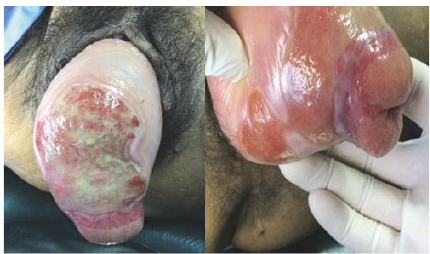
Figure 1: The prolapsed uterus was nonreducible due to the inflamed and edematous vaginal mucosa. An ill-defined ulcer measuring 5 × 6 cm was present in the anterior wall of the uterus with marked edema and ulceration of the surrounding tissue.